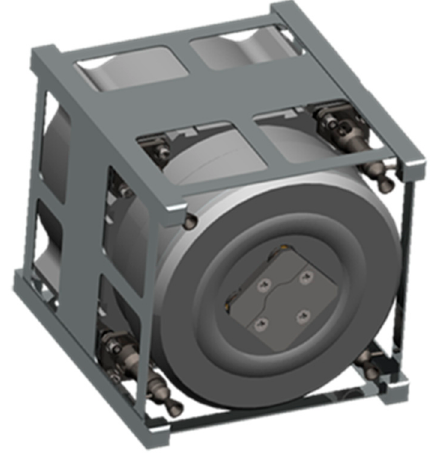
Figure 12. CHAMPS 1U Hydrazine Propulsion System [32].